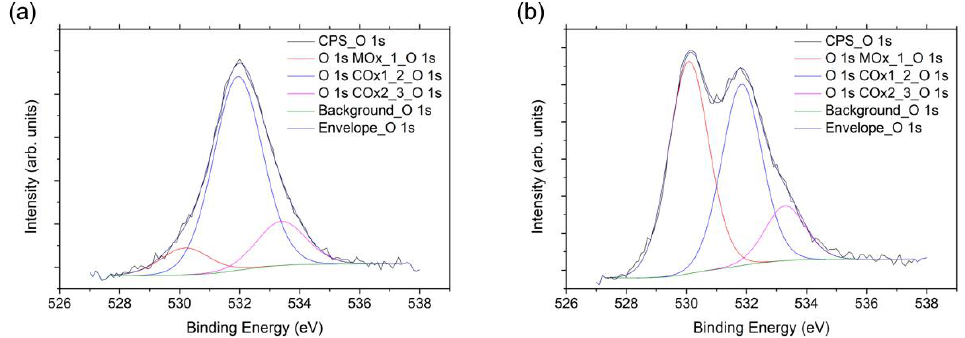
Figure 9. O 1s peak fits for the CNT fibers annealed at ( a ) 100 °C and ( b ) 500 °C showing the relative composition of oxygen content in the fibers varies, indicative of more metal oxide at the higher annealing temperature.